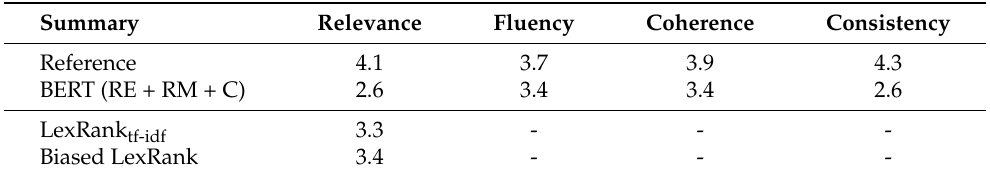
Table 5. Human evaluation results, on the modified human evaluation metrics using a 1–5 Likert scale. The first section of the table compares our BERT abstractive summarization method with reference summaries. The second section of the table compares the human-evaluated relevance score of the summaries generated by the vanilla LexRank and the Biased LexRank